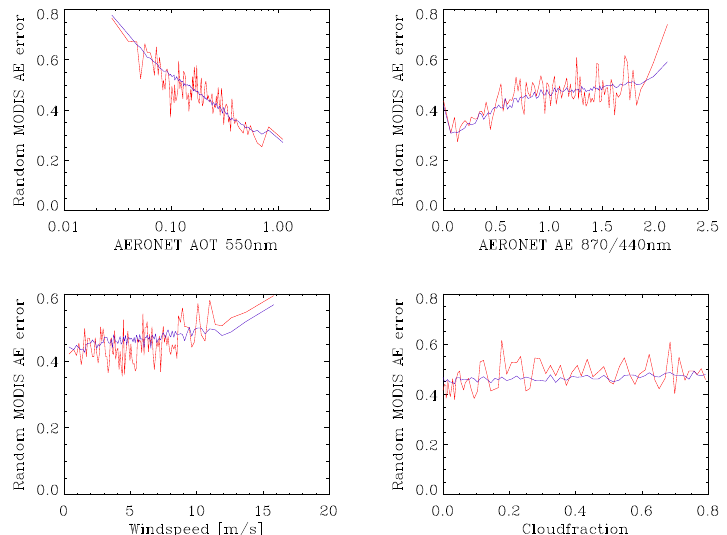
Fig. 19. Random Aqua AE errors in the corrected observations. In red, the error estimated from binned observations, in blue our error